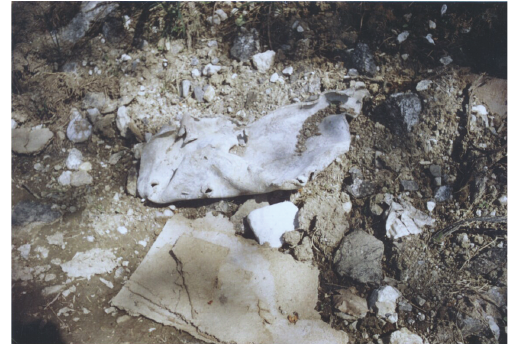
Figure 5: Waste material ( > 30m 3 ), parts of asphalt, gravel, lead plates which was used for building the road to the pasture, and drinking water; the photo shows a lead plate 20x60cm and weighing about